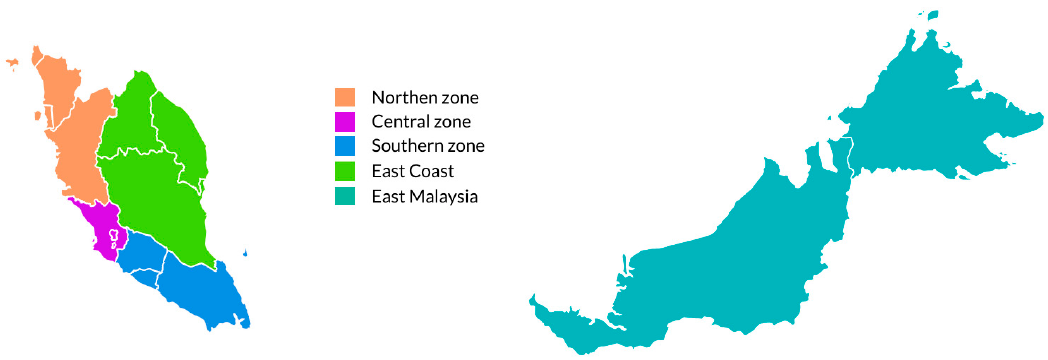
Figure 1. Locality of schools based on geographical areas.